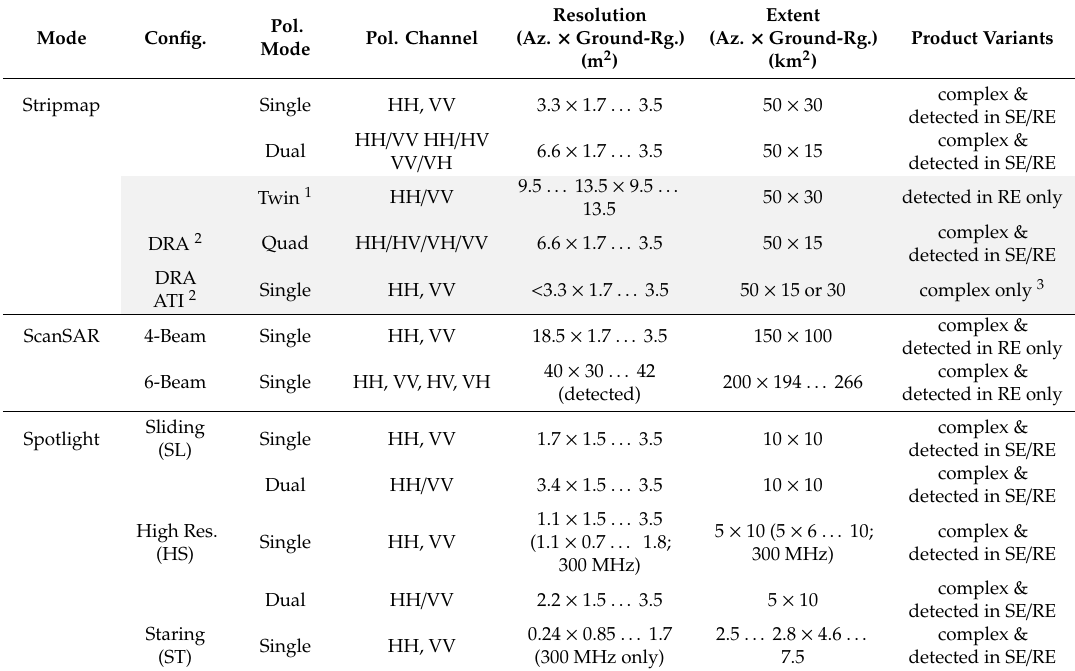
Table 1. TerraSAR-X basic and experimental (grey)